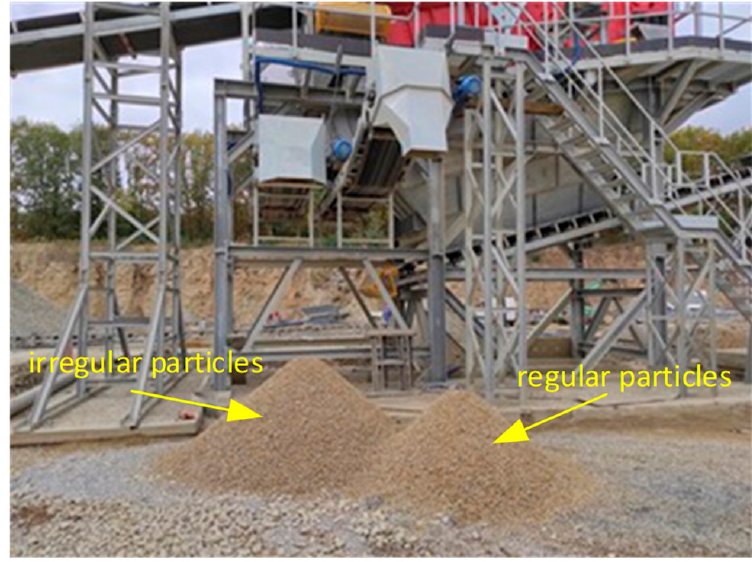
Figure 6. Limestone tests 8–16 mm regular and irregular particles .